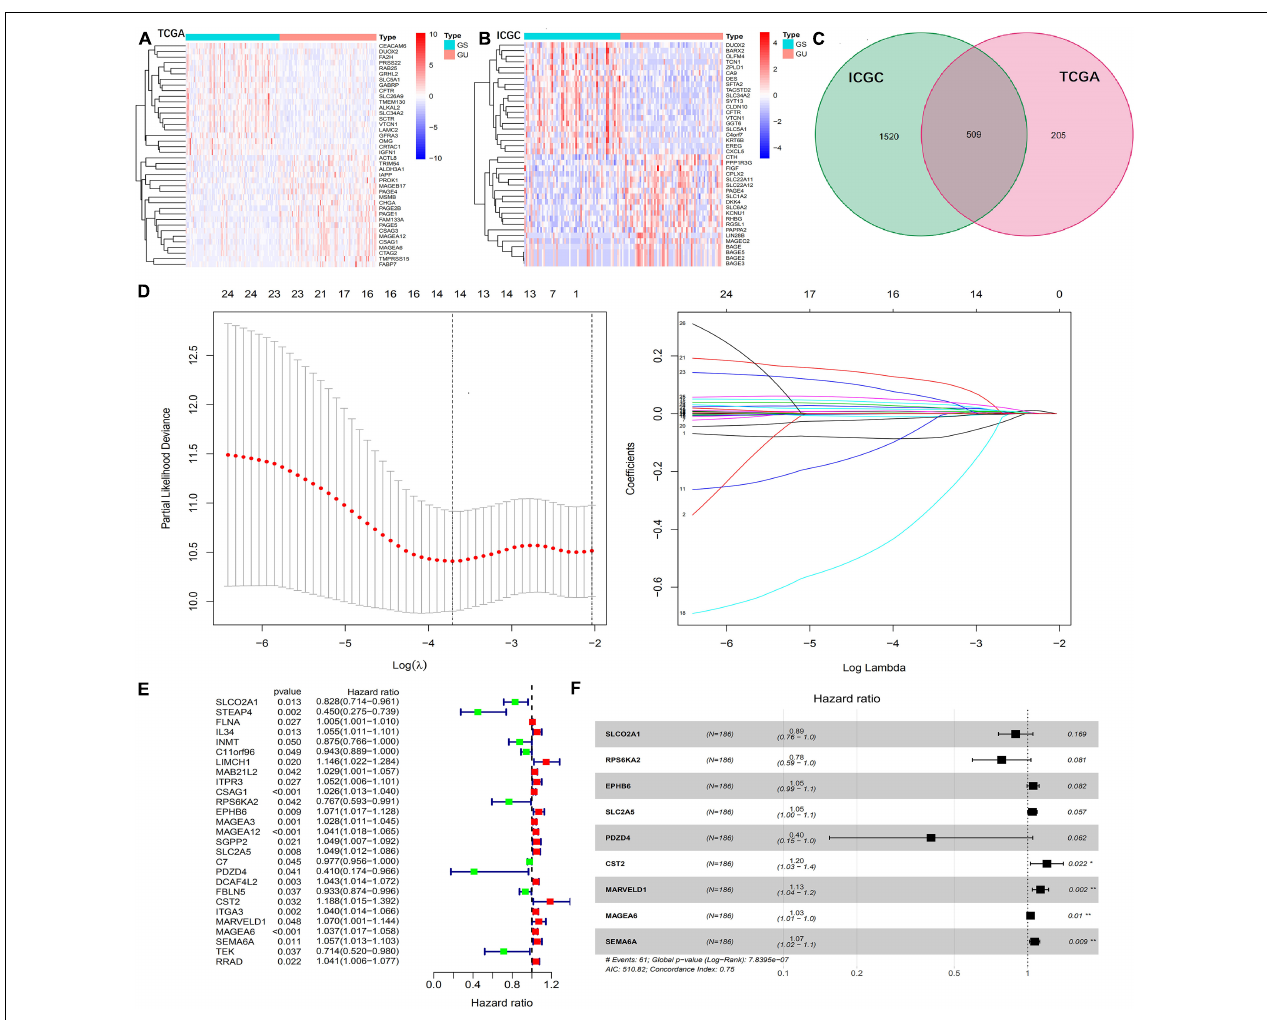
FIGURE 1 | Identification of GIGs and construction of a GIGSig. (A,B) Heatmaps of the top 20 differentially expressed genes between GS-like and GU-like group of the TCGA and ICGC profiles, respectively. (C) Intersect of GIGs of the TCGA and ICGC sets. (D) The results of LASSO analysis of OS-related GIGs. (E) Univariate Cox regression analysis of GIGs to identify 27 OS-related GIGs. (F) Multivariable Cox regression analysis to construct a nine-gene-based prognostic signature for HCC.